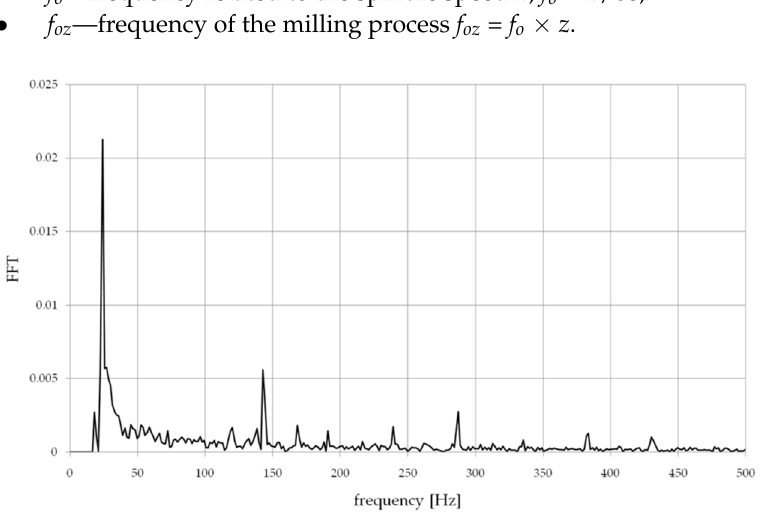
Figure 8. An example of the amplitude-frequency analysis of the displacement of the milled wall.